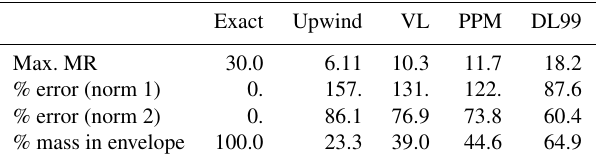
Table 3. Performance of simulations performed with the Upwind, VL, PPM and DL99 vertical advection schemes relative to the dis- cretized exact solution for Case 1: percent relative error in (cid:107)·(cid:107) 1 and (cid:107)·(cid:107) 2 and percent of total tracer mass contained in the correct envelope.